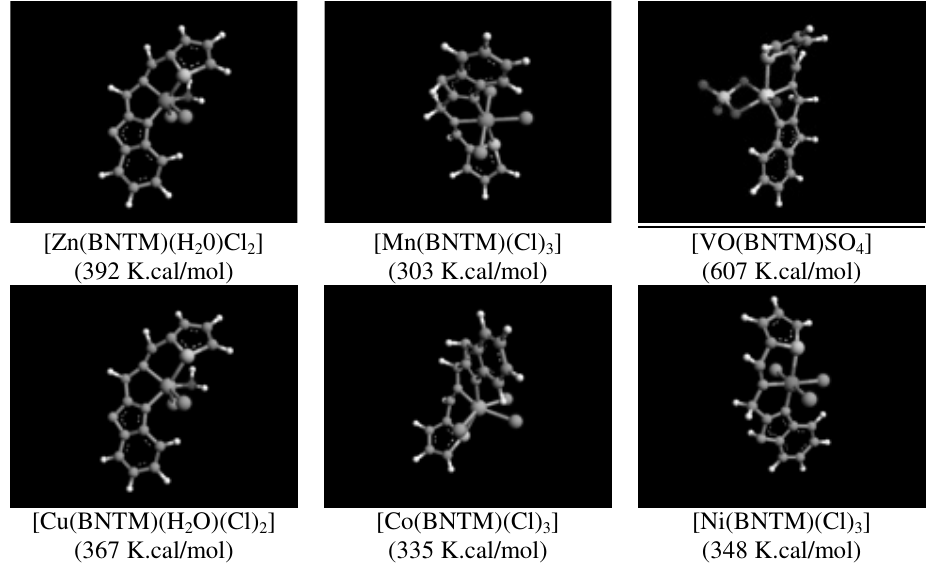
Figure 4. Molecular modelling structures for metal complexes